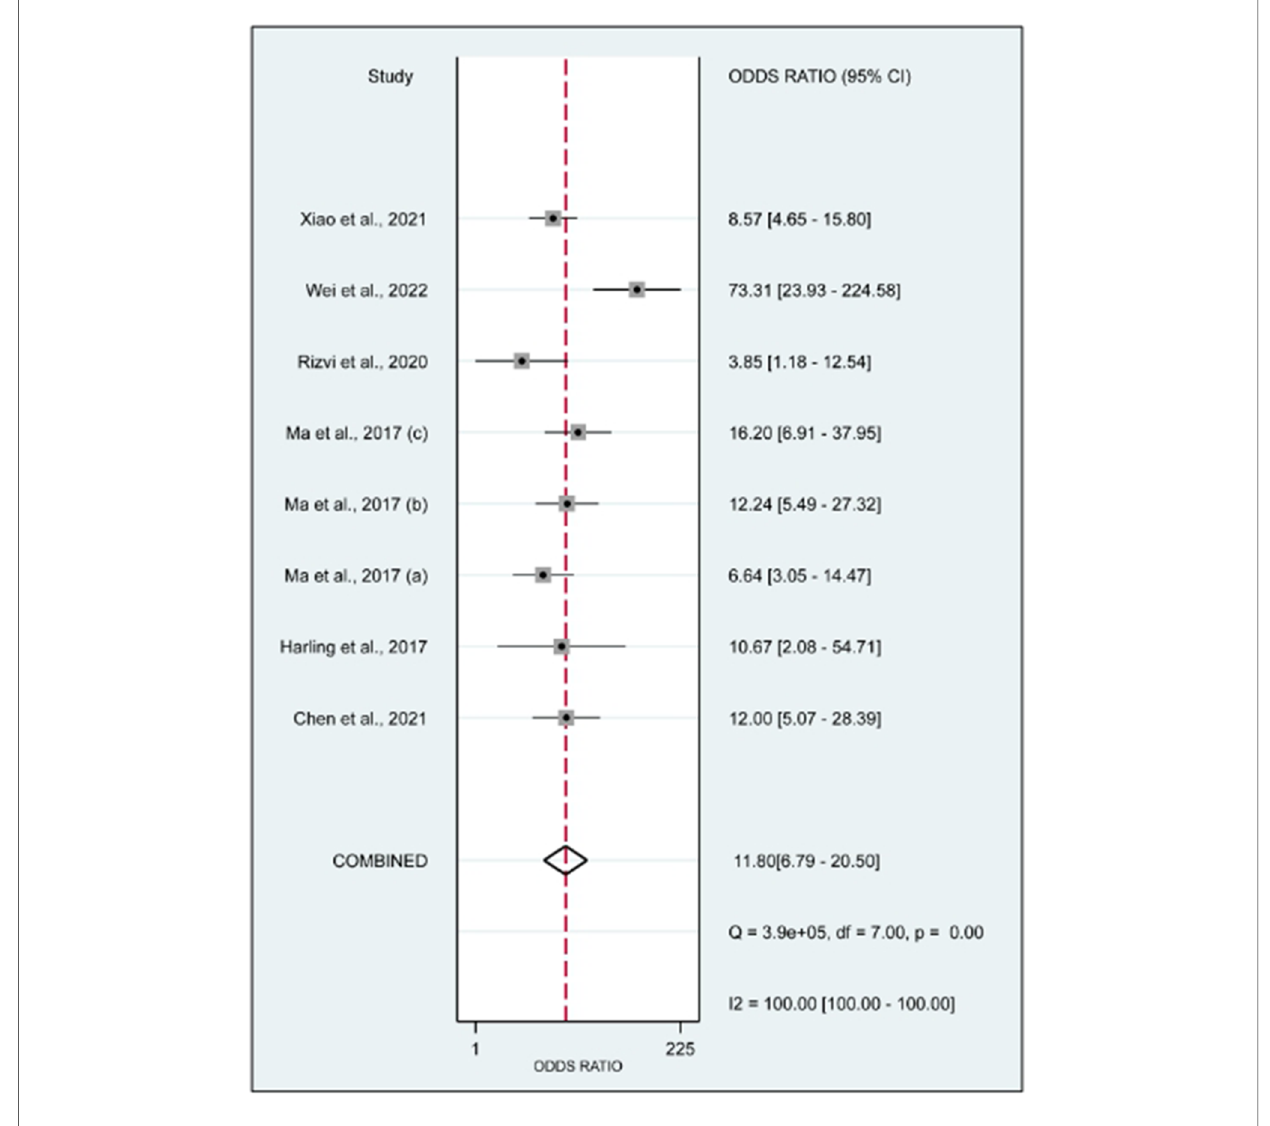
FIGURE 6 Forrest plot of the diagnostic odds ratio. The DOR was 11.80 (95% CI, 6.79 – 20.50; p